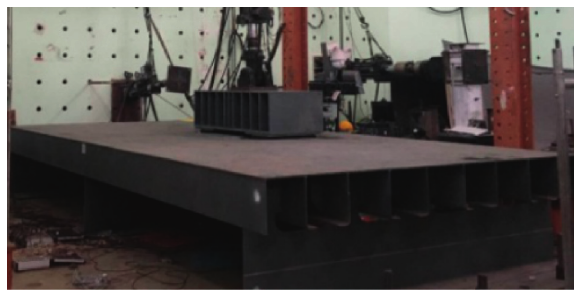
Figure 6: Test scene of new steel bridge deck.